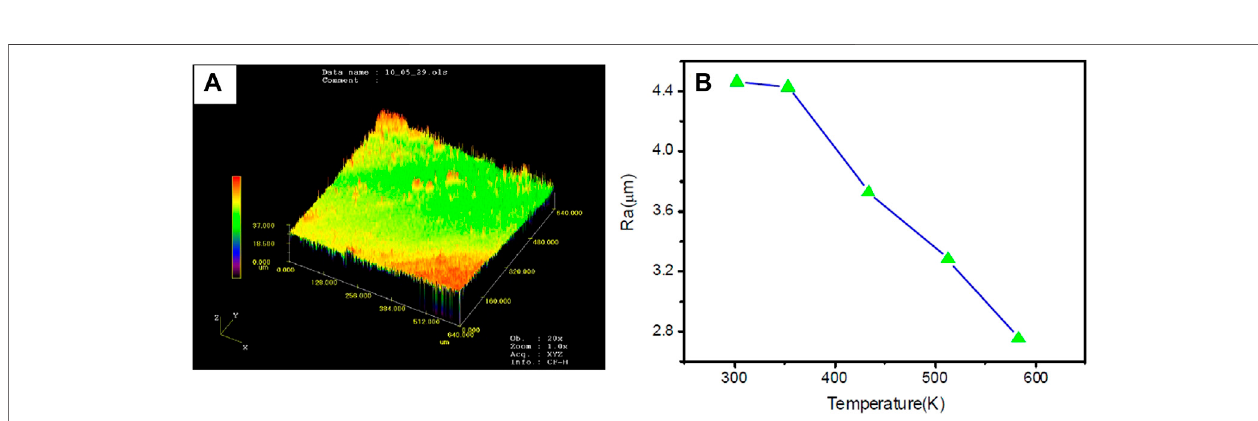
FIGURE4|(A) ThetypicalLSCMimageoftheTi-basedBMGsamplestestedat303 Kand (B) thesurfaceroughnessofthesamplesasafunctionofthetestingtemperatures.